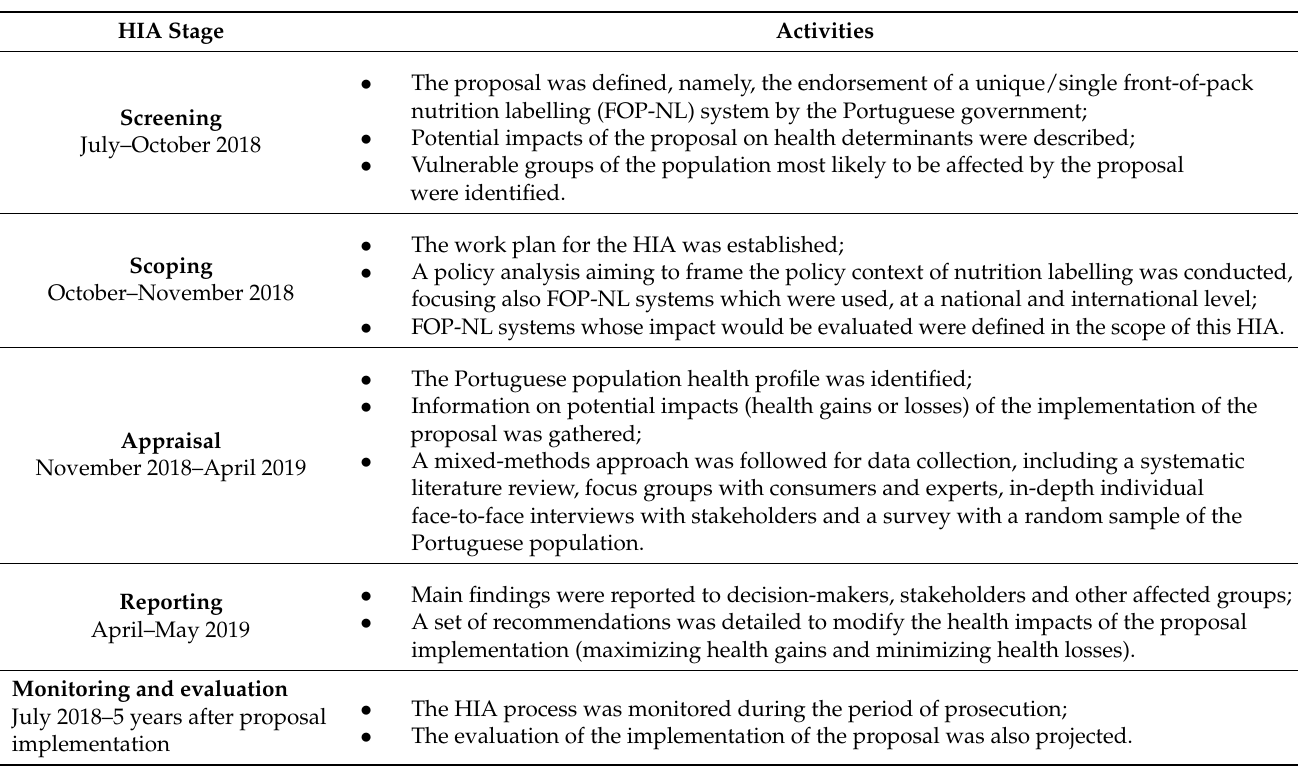
Table 1. Stages of HIA process and respective